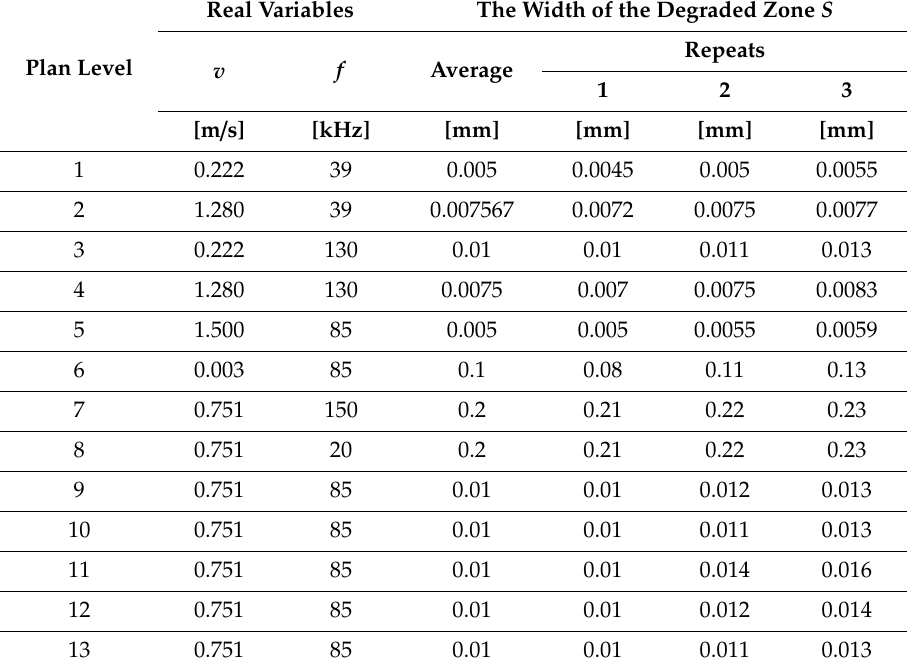
Table 7. The matrix of the experiment plan according to the five-level plan with the results for the film thickness t = 80 µ